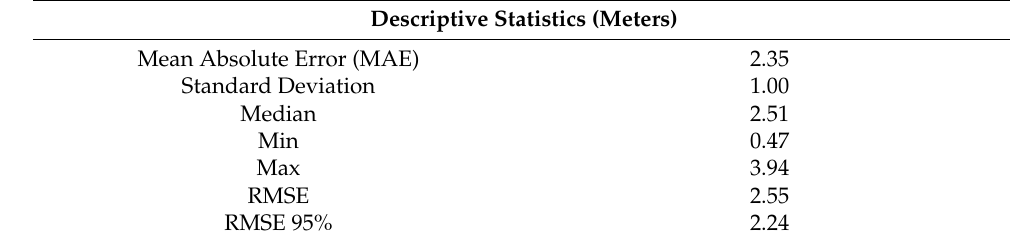
Table 7. Verification of calculated building